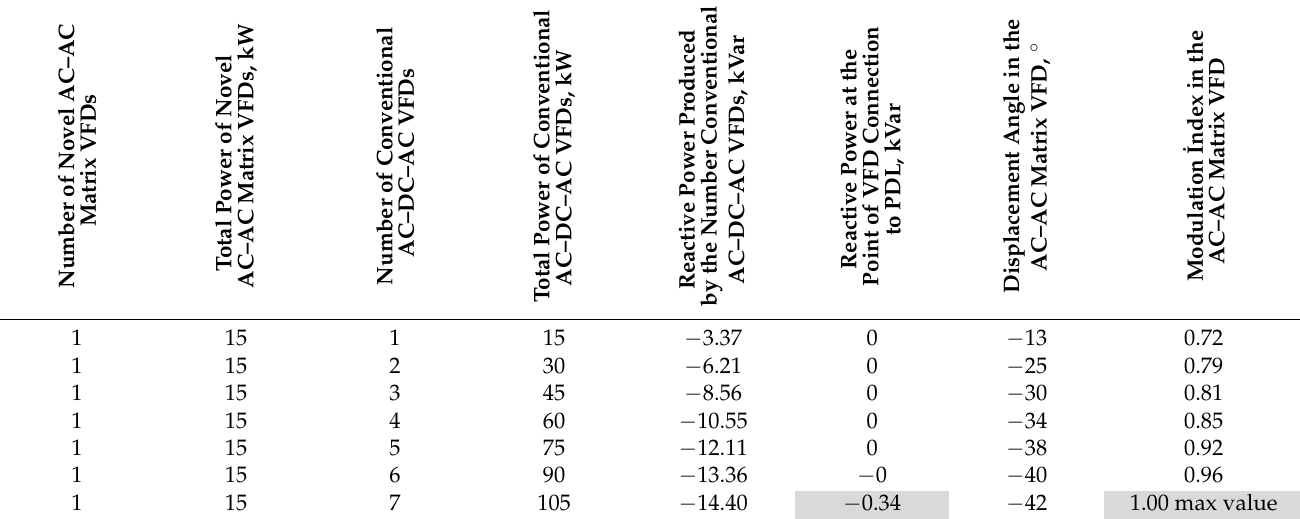
Table 5. Reactive power at the point of the VFD connection to the